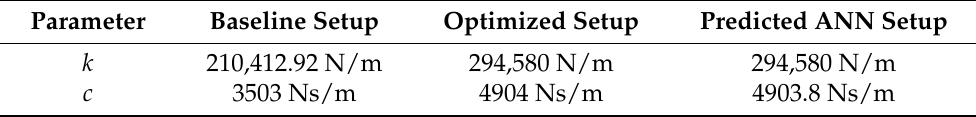
Table 4. Comparison between the baseline, optimized and predicted ANN setup.